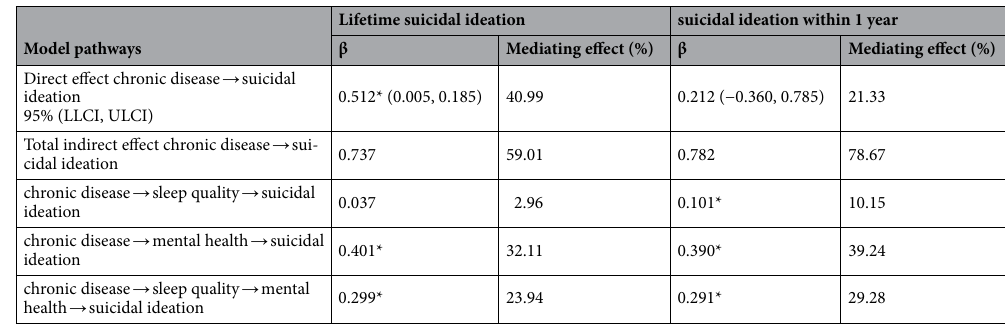
Table 4. The total, direct, and indirect effects of chronic disease on suicidal ideation (N = 2646). p <0.05.